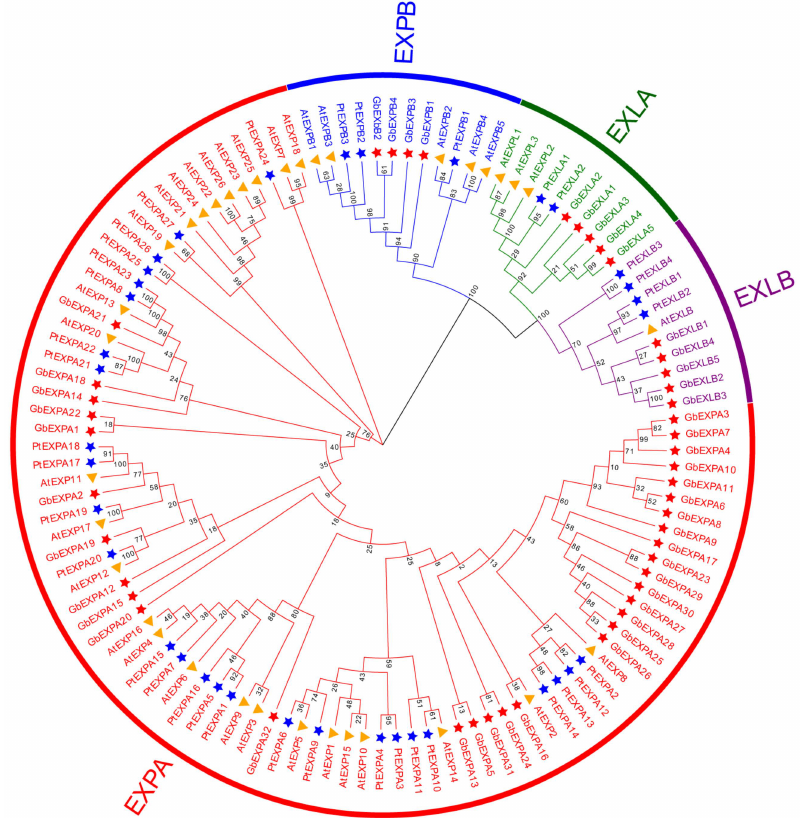
Figure 1. Bayesian phylogenetic tree of all expansin proteins from Ginkgo biloba , Arabidopsis thaliana , and Populus trichocarpa . Clades in red, blue, purple, and orange branches refer to the EXPA , EXPB , EXLA , and EXLB subfamilies, respectively. EXP genes are marked by orange triangles, blue stars, and red stars for Arabidopsis , Populus trichocarpa , and Ginkgo biloba ,